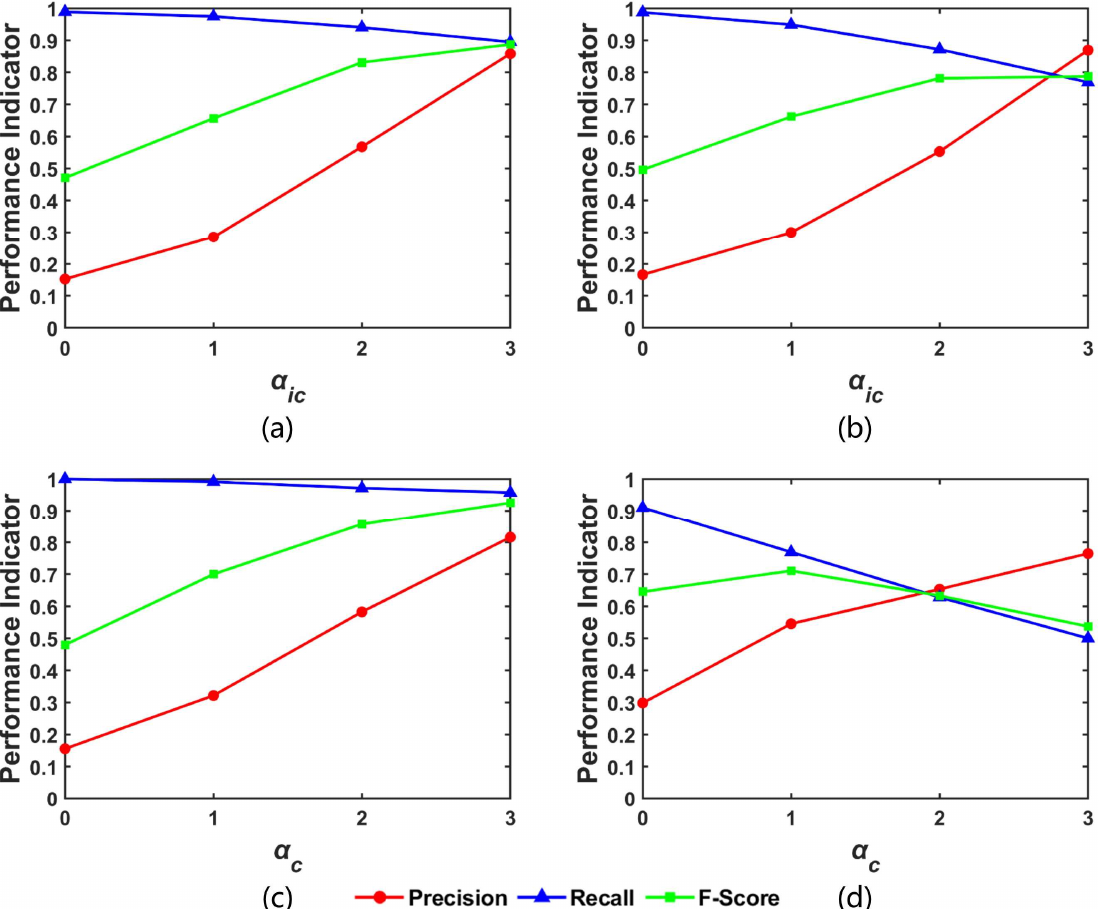
Figure 11. The influence of the threshold coefficient on leakage detection performance in two time series data sets based on two methods: ( a ) the single-feature-based method on the steady-state time series data set; ( b ) the single-feature-based method on the water-consumption time series data set; ( c ) the CUSUM method on the steady-state time series data set; ( d ) the CUSUM method on the water-consumption time series data set.